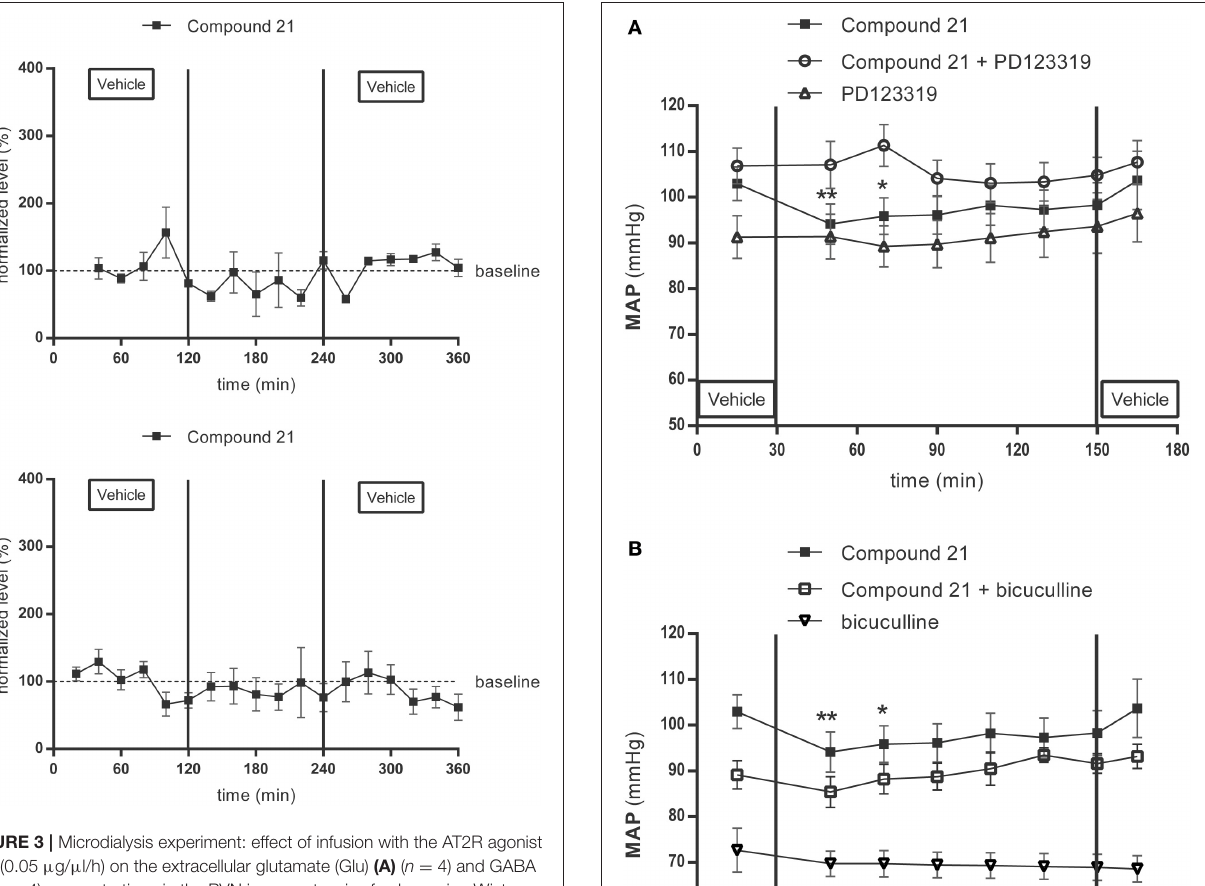
of C21 (Brouwers et al., 2015), and with those of Dai et al. (2015, 2016) who also reported that icv infusion of the AT2R antagonist had no effect on basal blood pressure. These authors further suggested that endogenous AT2R activation in the brain protects against the development of DOCA/salt induced hypertension in female, but not in male rats (Dai et al., 2015,